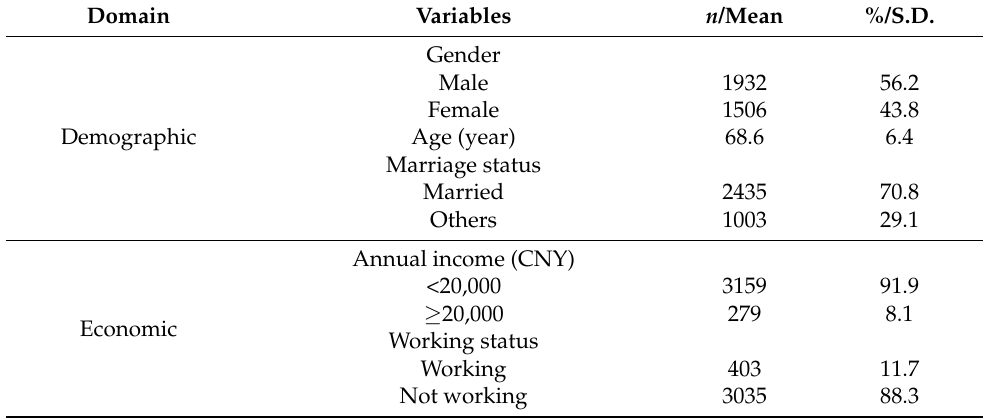
Table 1. Characteristics of